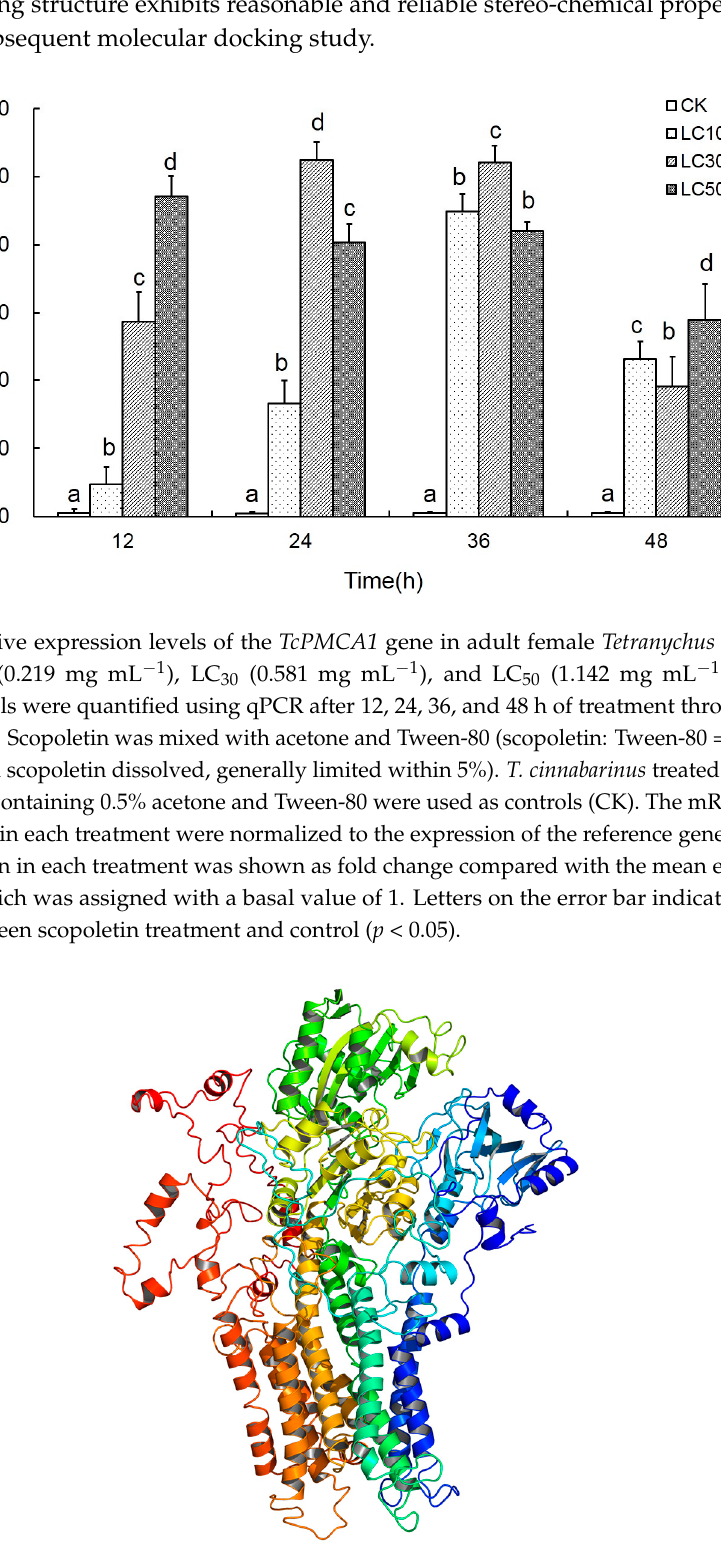
Figure 6. Homology modeling 3D-structure of TcPMCA1 .